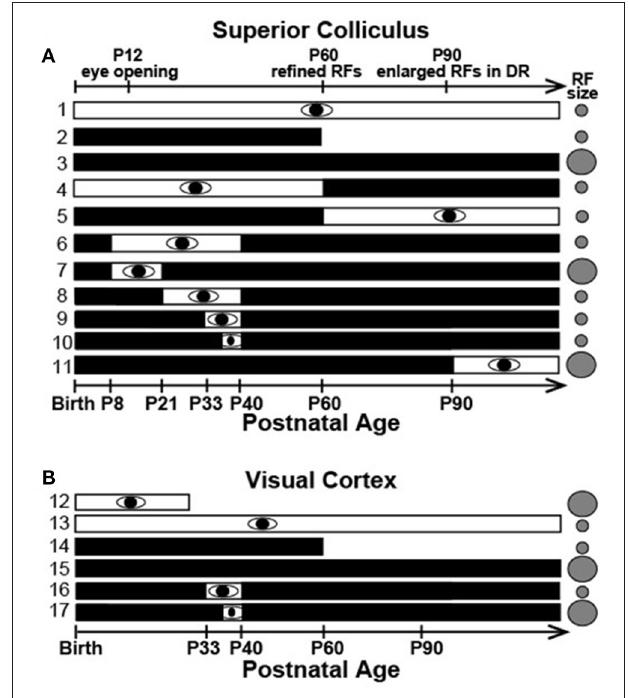
FIGURE 5 | Summary of previous data on timing of RF refinement and sensitivity to visual deprivation. Refinement occurs normally in the dark but late postnatal visual experience is required to maintain adult RFs in both (A) SC and (B) V1. White and black bars indicate timing of light and dark rearing, respectively. Gray circles indicate adult RF size (Modified from Balmer and Pallas, 2015a, used with permission).